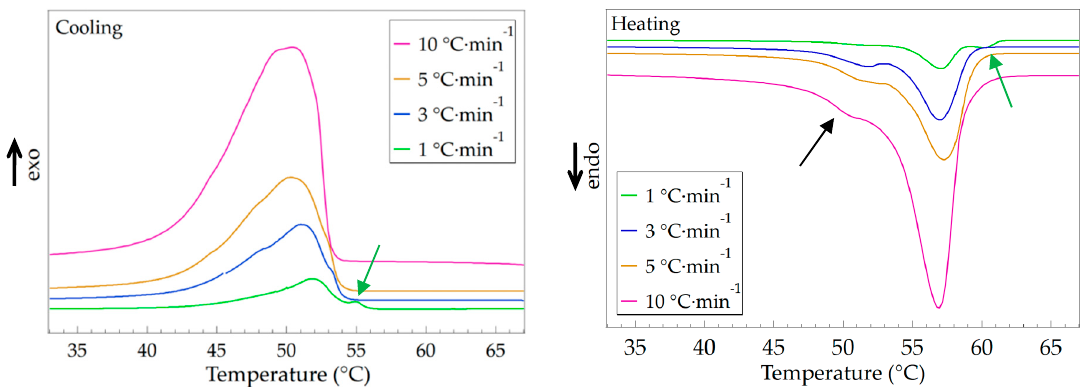
Figure 5. DSC curves of the MC(BeA- co -MMA)3 microcapsule measured at different temperature changing rates (including 1 °C·min –1 , 3 °C·min –1 , 5 °C·min –1 and 10 °C·min –1 ) in the cooling (left) and heating (right) processes. Table 4. Thermal properties of the MC(BeA- co -MMA)3 microcapsule measured at different temperature changing rates (including 1 °C·min –1 , 3 °C·min –1 , 5 °C·min –1 and 10 °C·min –1 ).